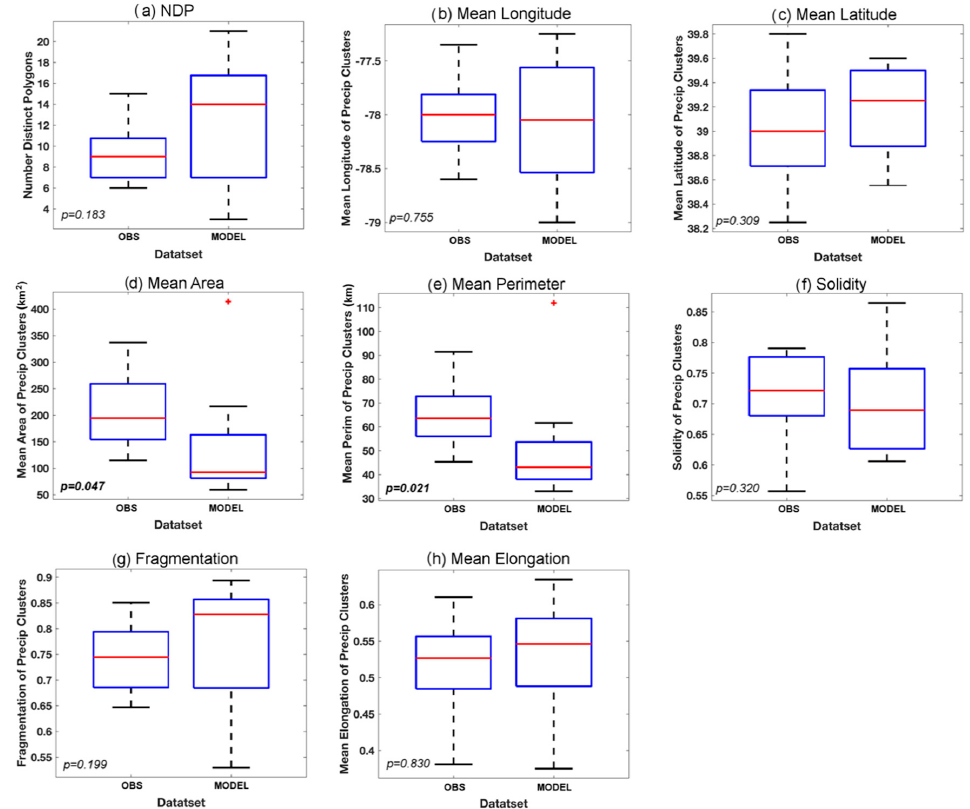
Figure 5. Box plots showing distributions of object-based metrics calculated for the 0.254 mm h − 1 threshold for the 12 UTC HRRR model cycle (MODEL) versus those same metrics for the Stage IV observations (OBS) for the 30 July 2016 event. The corresponding Mann–Whitney U-test p -values are included in italicized text in the lower left corner of each plot. For p < 0.1, these p -values are also in bold face font.